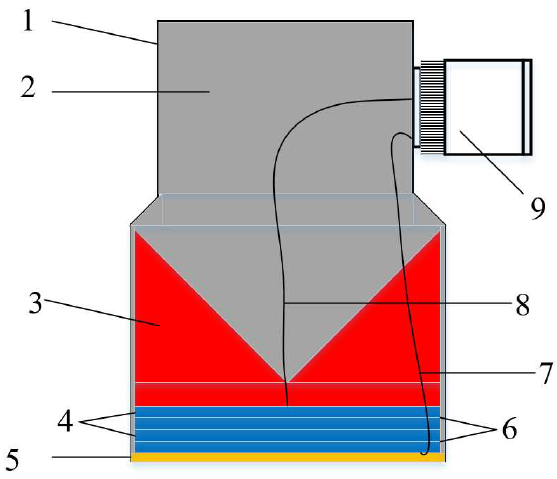
Figure 1. Structure of four-laminated transducer (1. case, 2. epoxy potting, 3. backing material, 4. piezoelectric wafers, 5. matching layer, 6. copper sheet, 7. ground wire, 8. signal wire, and 9.